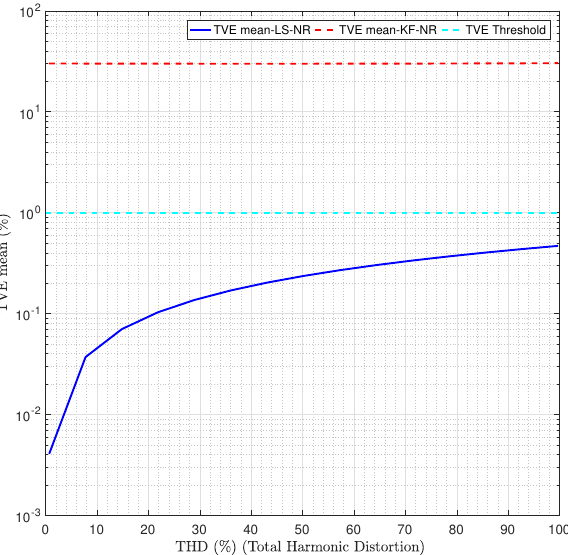
Figure 4. Mean TVE versus total harmonic distortion ( THD ).